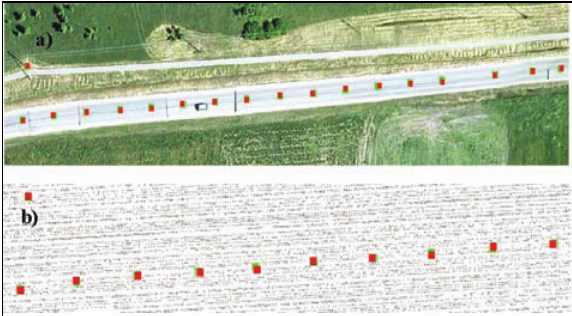
2 pav. Marijampolėje tikrintų LIDAR aukščio taškų fragmentas: a – ortofotografinis modelis; b – lazerio taškų „debesis“ Fig. 2. Fragment of LIDAR height points checked at city Marijampolė: a – orthophotographic model; b – points